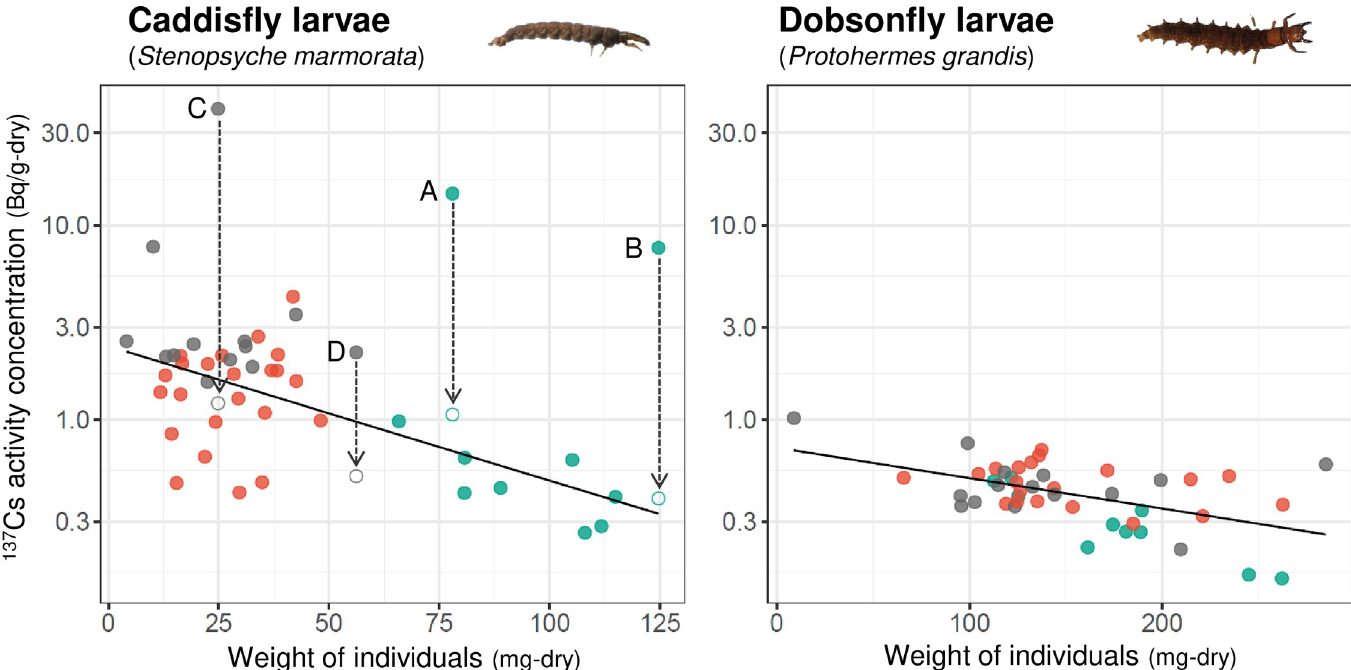
Fig 3. Relationship between 137 Cs activity concentration and weight of individuals in aquatic insects. Aquatic insects were collected at OD1 in summer (green), autumn (gray), and winter (red). Alphabets A to D indicate the sample ID where CsMPs were observed (see Table 2). White points indicate 137 Cs activity concentration from the samples after removing CsMPs. The lines represent linear model prediction (S2